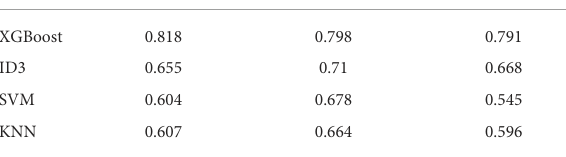
TABLE 4 Performance of prognostic models built by machine learning algorithms on the test data (area under the ROC